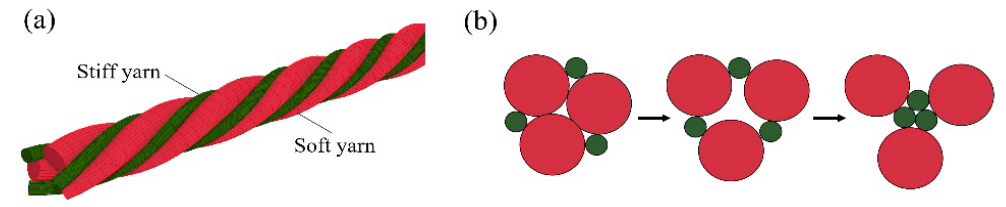
Figure 2. Six-ply auxetic yarn: ( a ) side view; and ( b ) cross-section views at different stretched states.